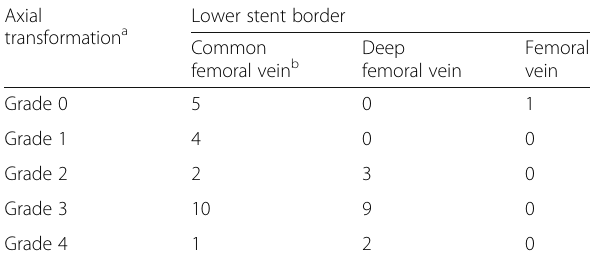
Table 2 Axial transformation of the deep femoral vein and lower stent border Axial transformation a